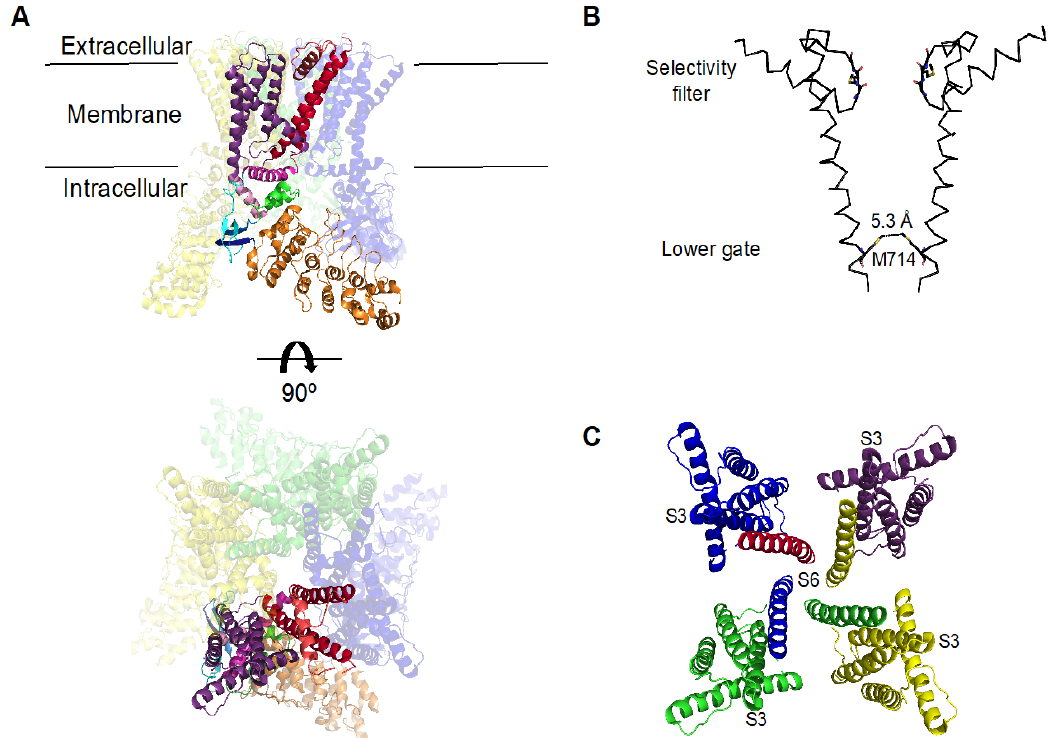
Figure 1. Structure of the TRPV4 channel. ( A ) Frontal view (top) and extracellular view (bottom) where one single subunit of the tetramer and each of its domains are shown in a different color (ARD in orange, β 1 and β 2 in blue, Helix Turn Helix in green, PreS1 in pink, S1–S4 in purple, S5–S6 in red, TRP box in magenta, and β 3 in cyan). The membrane boundary is delimited by the black lines. ( B ) TRPV4 pore diameter. The structures of S6 and the pore helix of two subunits are shown. The distance between the two M714 residues is represented by the black line. ( C ) Top view of S1–S4 and S6 domains. Subunit domains follow the same color scheme as in A. The 6BBJ PDB file was used to produce this figure [70].